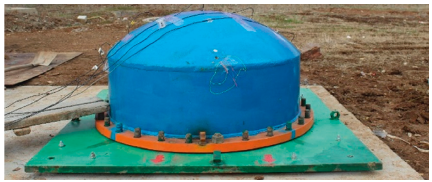
Figure 4: Test model for interior blast loading.